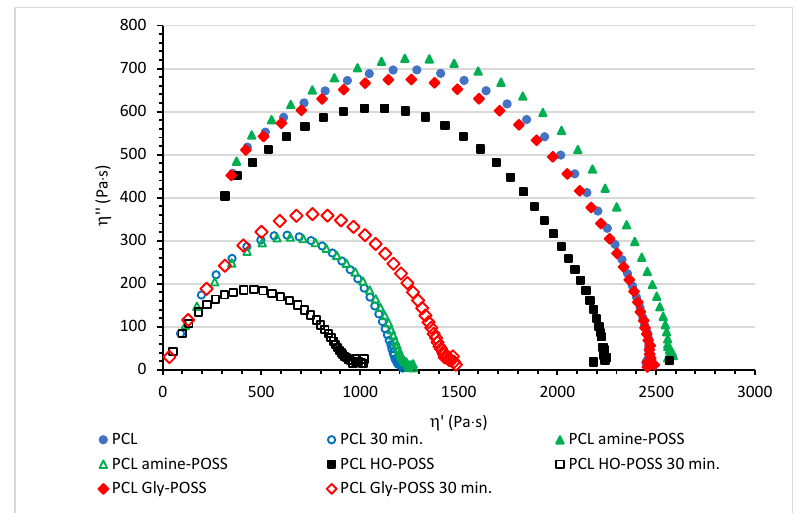
Figure 10. The Cole-Cole plots for PCL and PCL modified POSS at 100 ° C; η ′ —dynamic viscosity (Pa ⋅ s), η ″ —out of phase component of complex viscosity η * (Pa ⋅ s).